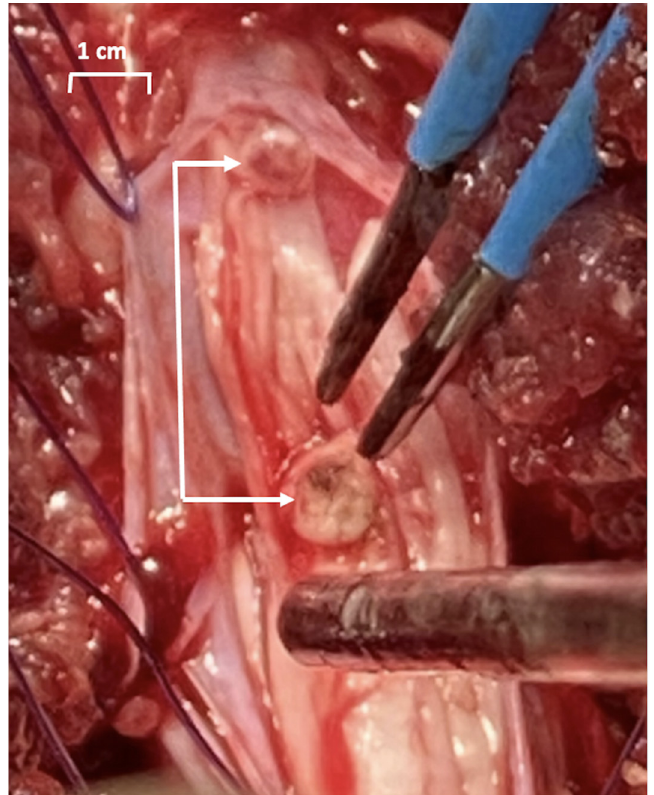
Figure 2. Photograph of the sacral spinal lesion during surgery. The sectioned part of the sacral levels of lesion are marked with arrows. The cauterizing electrodes (blue) and a suction tube are also shown.